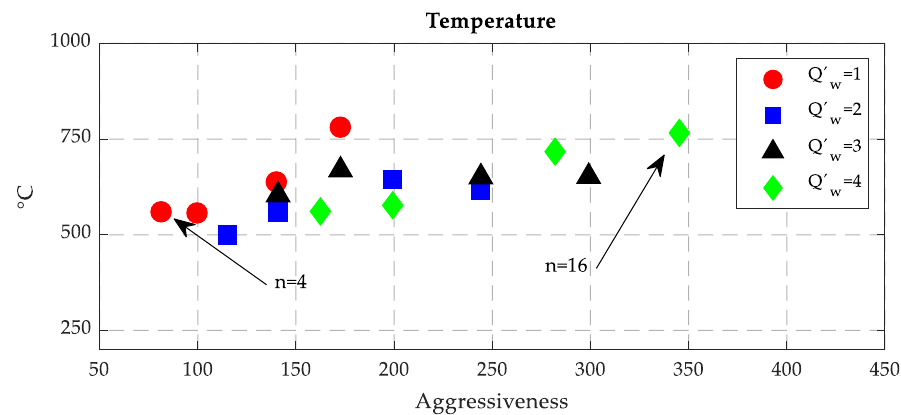
Figure 10. Simulated temperatures in the moment of thermal damage appearance based on the power measurement.